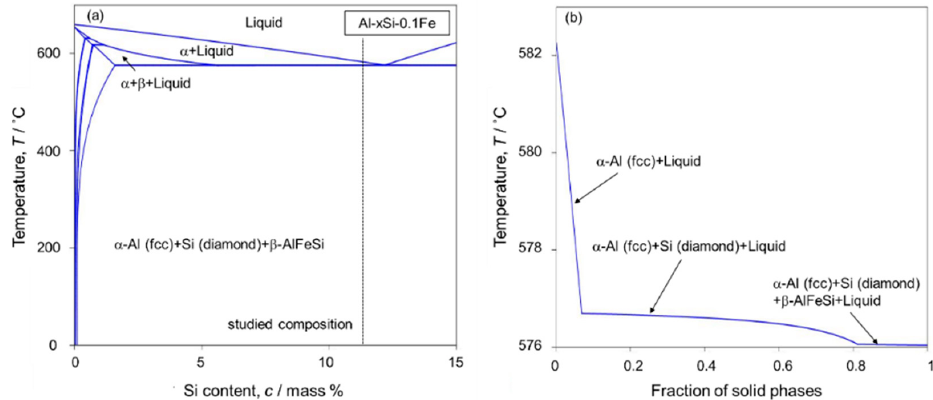
Figure 2. ( a ) Vertical section of Al–0.1mass%Fe in Al–Si–Fe ternary phase diagram and ( b ) Scheil simulation for the fraction of solid phases at various temperatures.